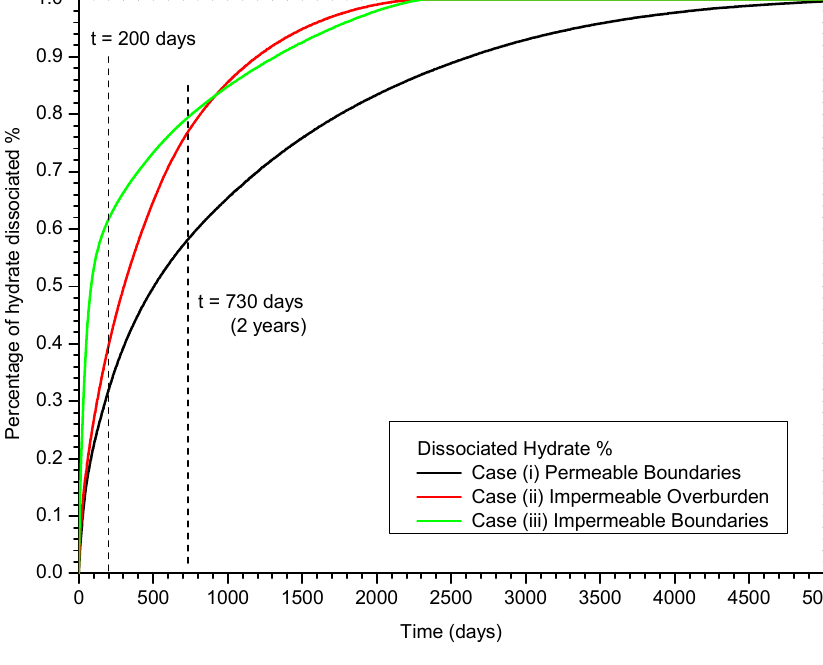
Figure 10. Effect of the permeability of the boundaries on Q